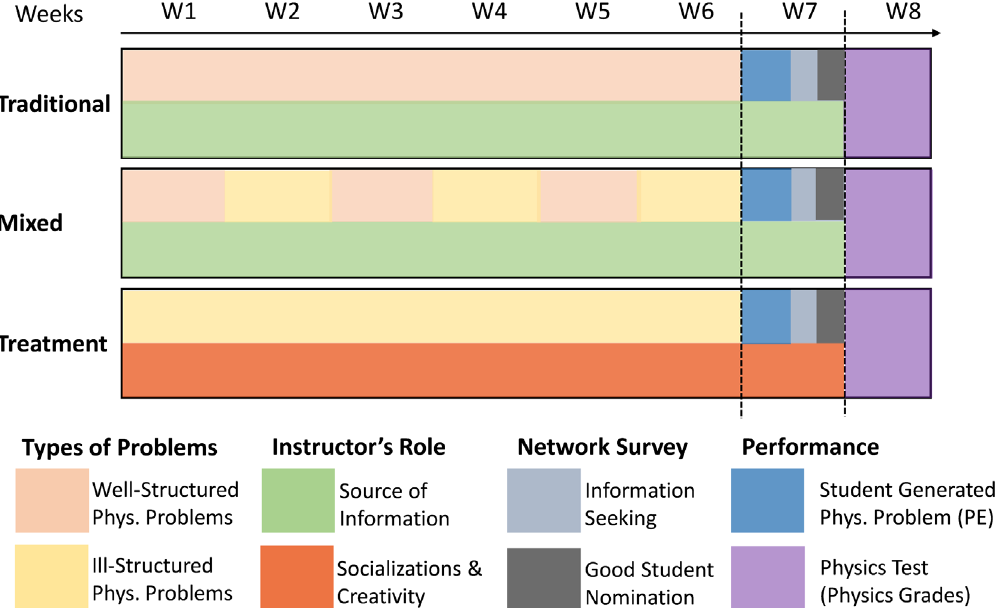
FIG. 1. Experiment design, with three sections: traditional, mixed and treatment. The diagram shows the timeline of the events from weeks 1 through 8. Includes the unique instructional characteristics per section (types of problems, and instructor ’ s role), along with performance instruments and network